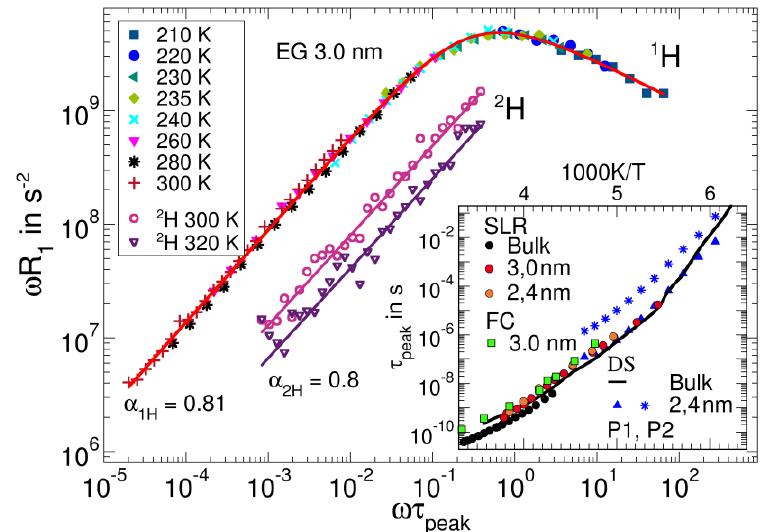
Figure 12. FC 1 H and 2 H NMR susceptibilities of ethylene glycol in cylindrical silica pores with a diameter of 3.0 nm. For 1 H, the susceptibility master curve constructed by horizontally shifting the data sets at the indicated temperatures is shown together with a HN fit (red line), yielding the shape parameters α = 0.81 and β = 0.45. For 2 H, the susceptibilities at 300 K and 320 K are interpolated with power laws ω 0.8 and shifted horizontally for better visibility. The inset compares the correlation times obtained from the position of the 1 H susceptibility peak at 235 K and the shift factors used for the construction of the master curve with correlation times from HF 2 H relaxation and DS studies on ethylene glycol in various silica pores and in the bulk [137,138,142]. DS studies find two dynamic processes, P1 and P2, from which P1 corresponds to the main NMR ( α ) relaxation